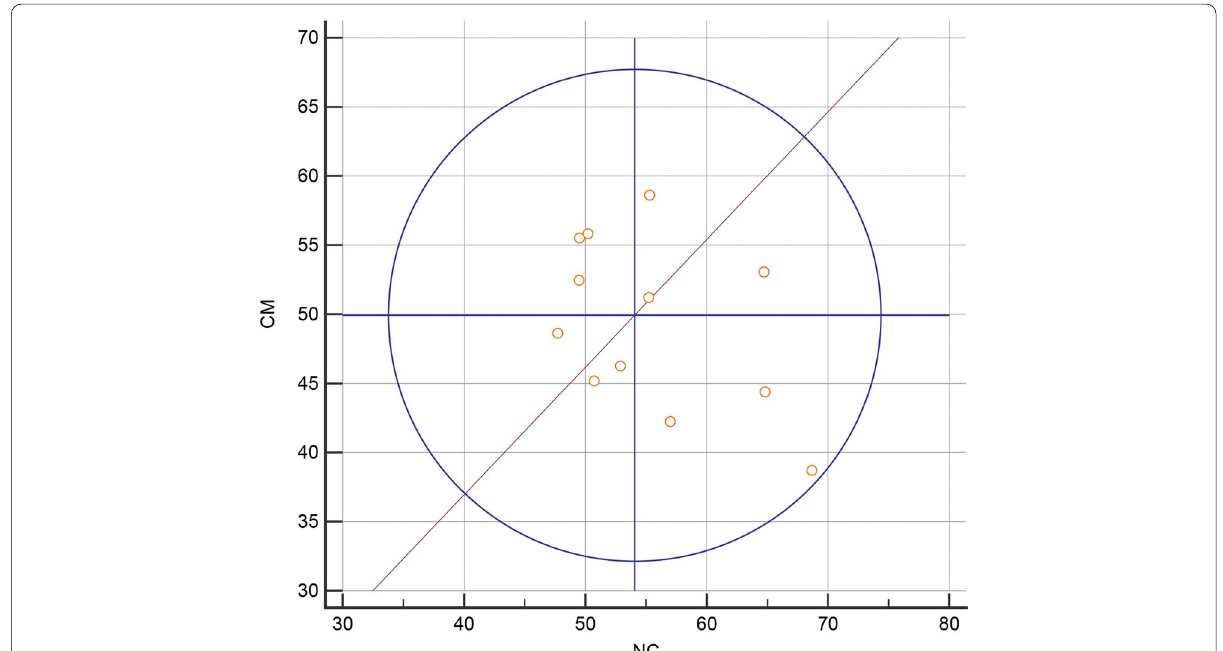
Fig. 4 Youden plot for the CBF value of CM and NC, which indicated a small total error with all the points in the circle. The circle represented the 95% coverage probability, and all the point in the circle with a small total error